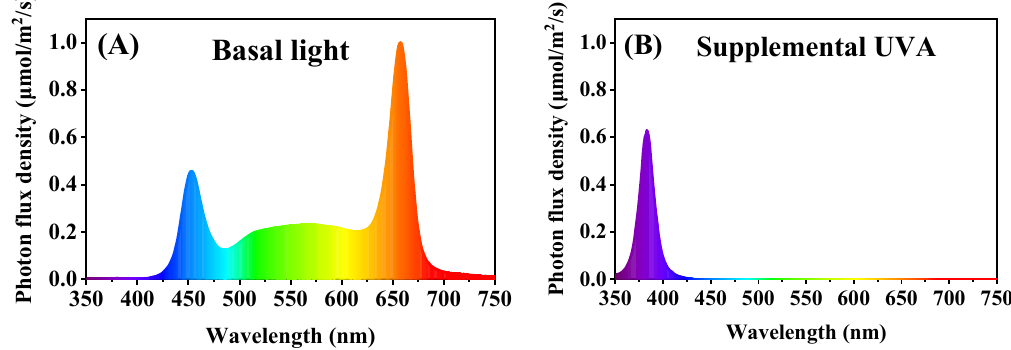
Figure 13. Light spectra of basal light ( A ) and supplemental UVA ( B ).